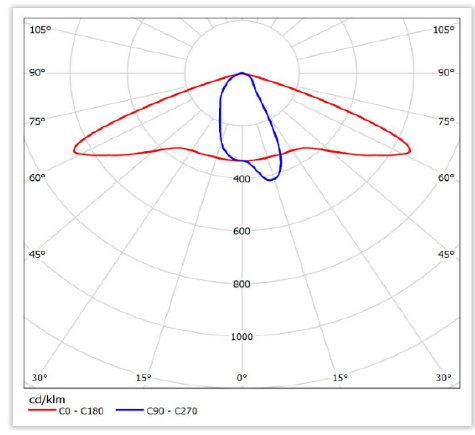
Figure 5. View of road luminaire LED_26W—manufacturer’s catalogue data. Table 2. Technical parameters of LED_26W luminaire.